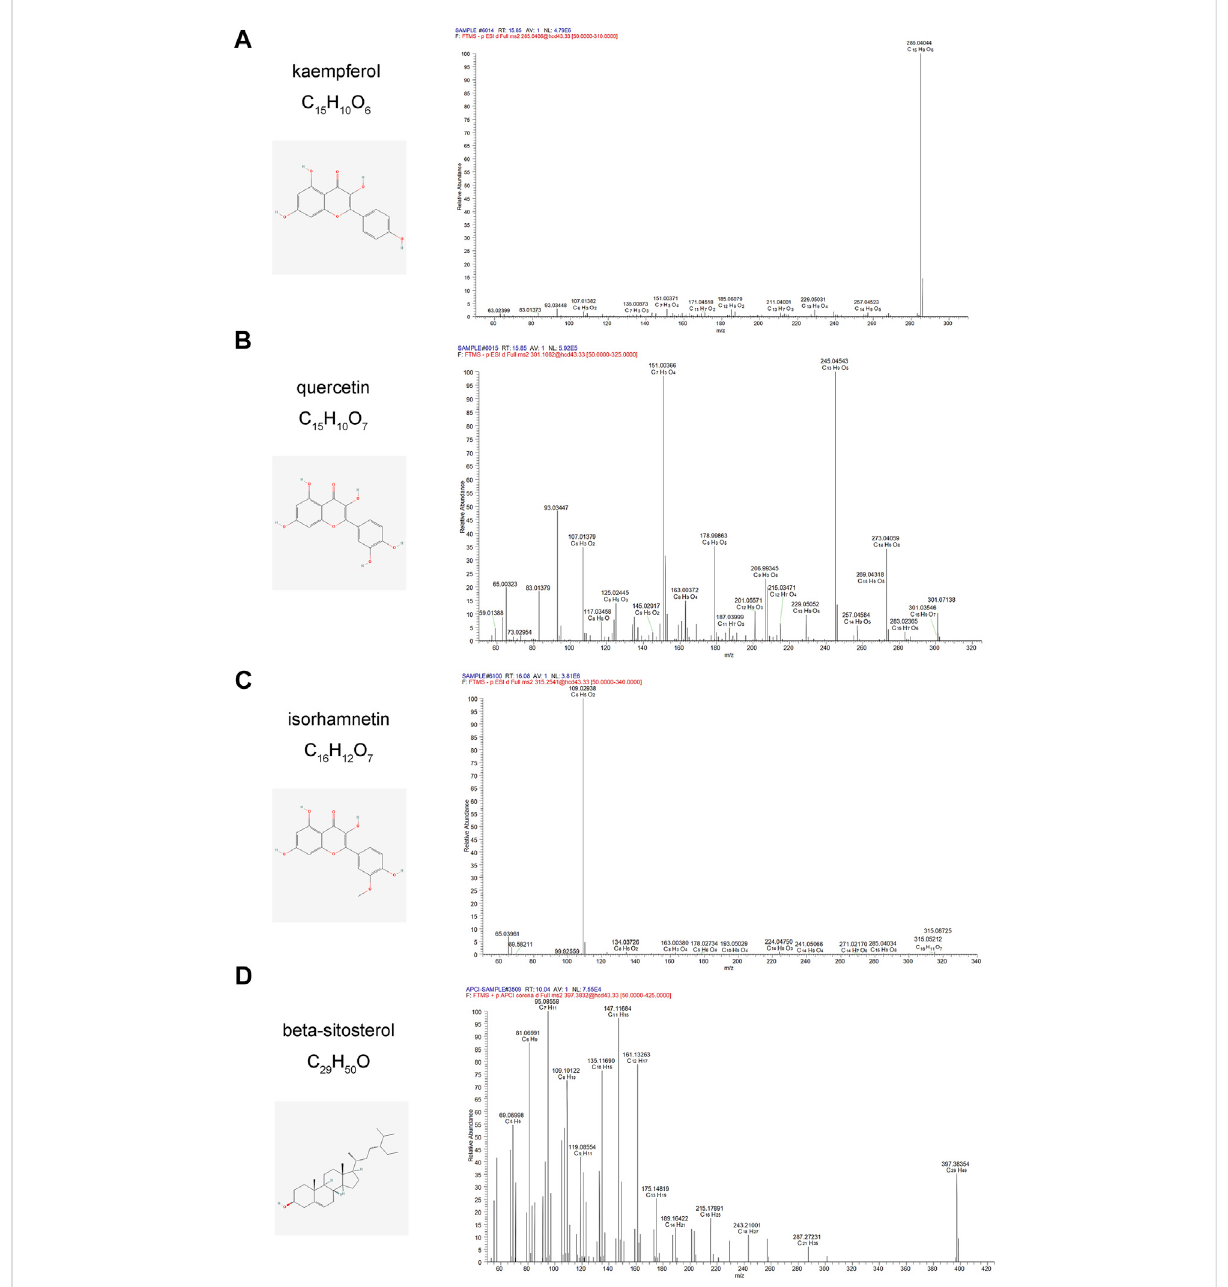
FIGURE 10 Mass spectrum of kaempferol, quercetin, isorhamnetin, and beta-sitosterol from CCMM extract in the negative and positive ion modes, respectively. (A) ESI-MS/MS spectra of kaempferol from CCMM extract. (B) ESI-MS/MS spectra of quercetin from CCMM extract. (C) ESI-MS/MS spectra of isorhamnetin from CCMM extract. (D) APCI-MS/MS spectra of beta-sitosterol from CCMM